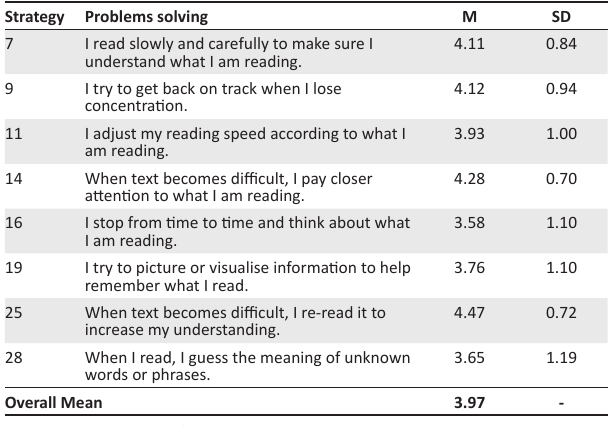
TABLE 2: Problem Solving Strategies.